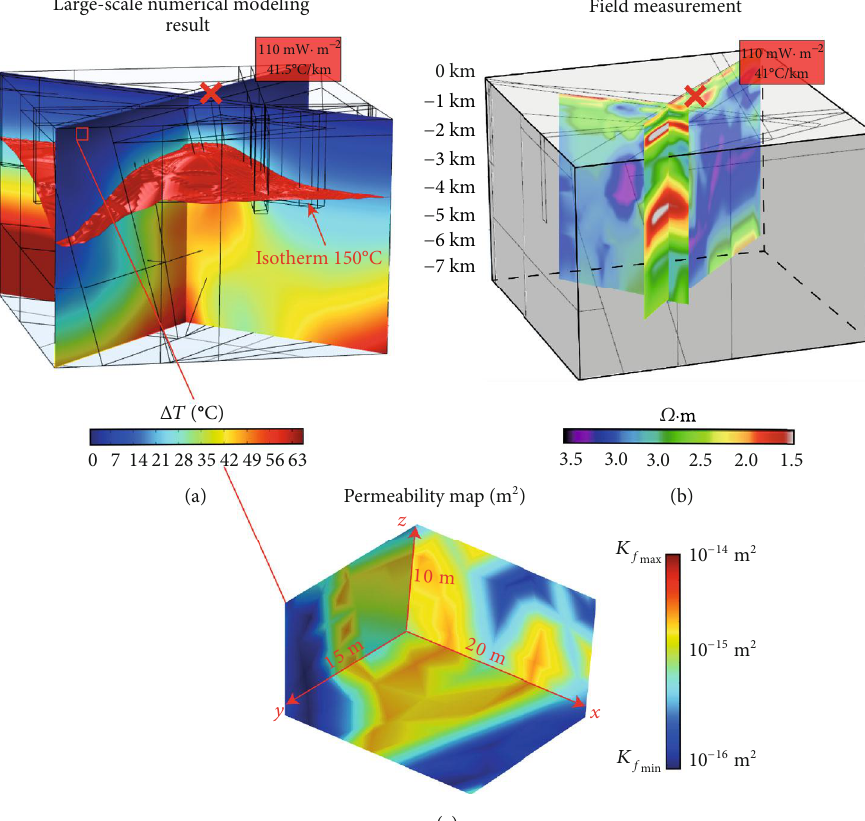
Figure 13: Pontgibaud large-scale numerical simulation results (a) for a maximum permeability imposed on the Pontgibaud CFZ of 1 × 10 − 14 m 2 (c) are compared with the resistivity pro fi les, the geothermal gradient, and the heat fl ux (b). Fluid velocities vary from 10 -8 to 10 - 10 m · s -1 . This permeability variation is the result of Equation